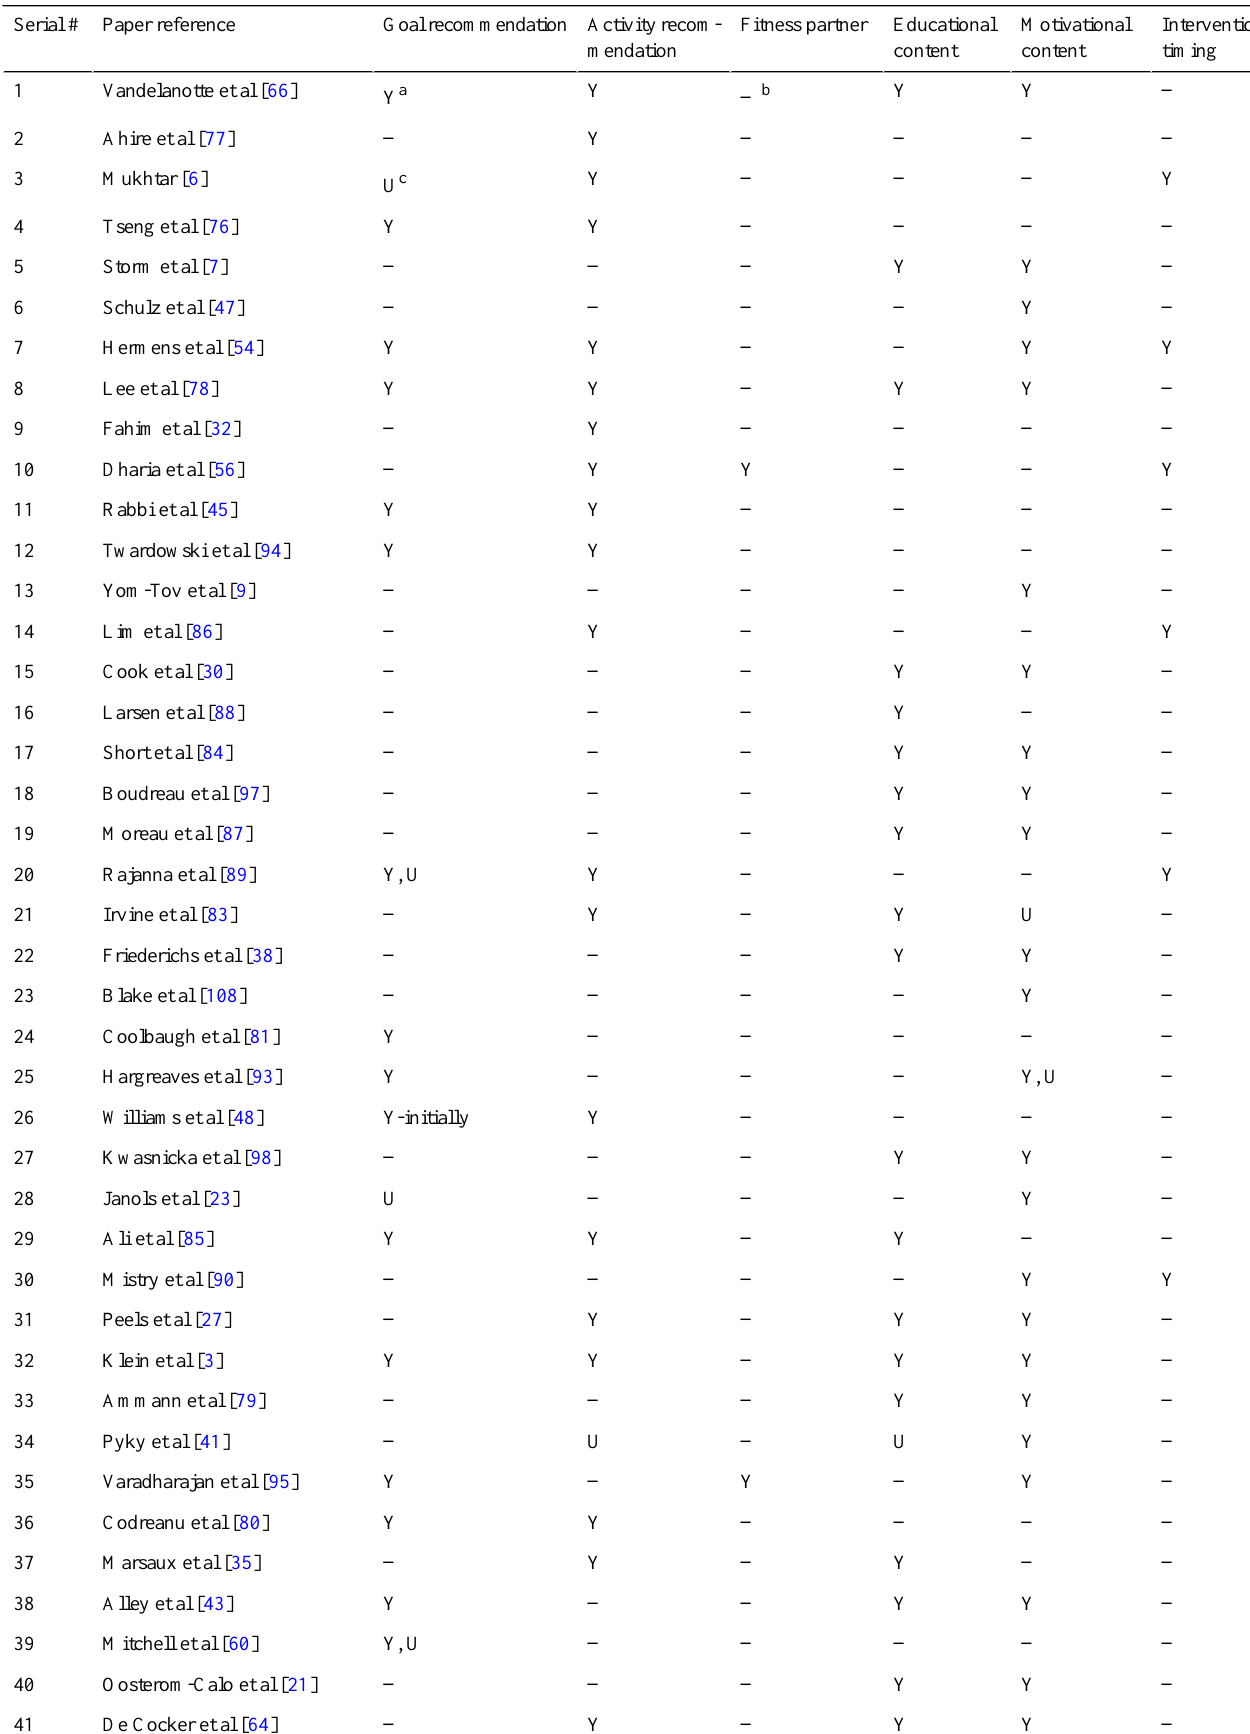
Table 2. Personalization